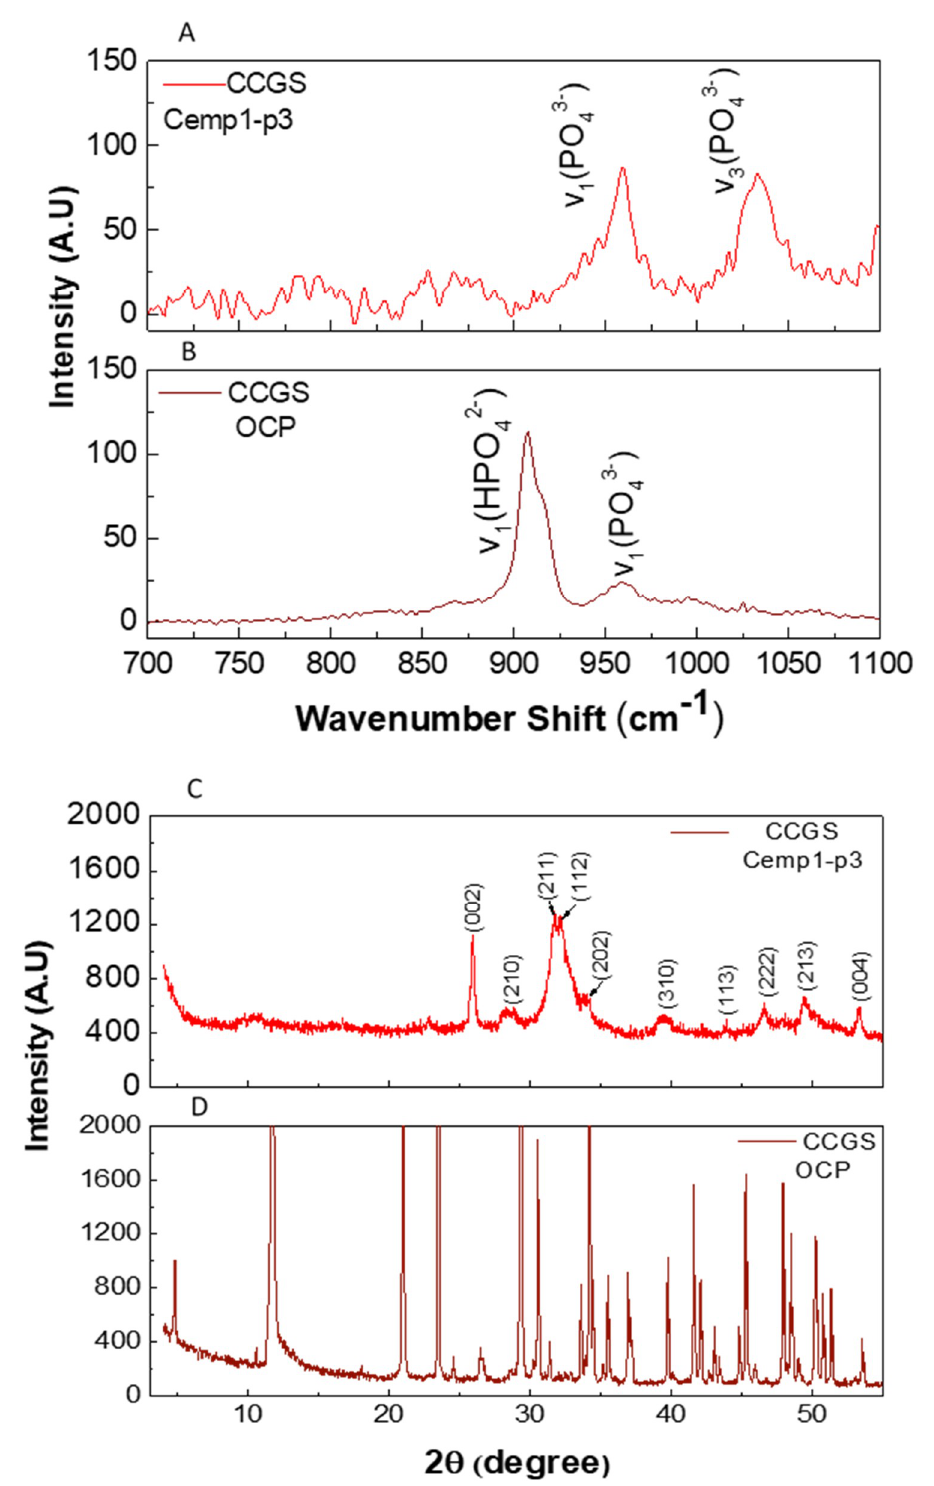
Figure 6. Raman spectra and XRD patterns of samples obtained after CCSG process. ( A ) Raman spectra corresponds to HA bands (experimental), ( B ) Raman spectra corresponds to the OCP bands (control), ( C ) HA crystalline phase (experimental) and ( D ) Reflections of the crystalline planes of OCP (control). CCGS (constant composition seeded growth).